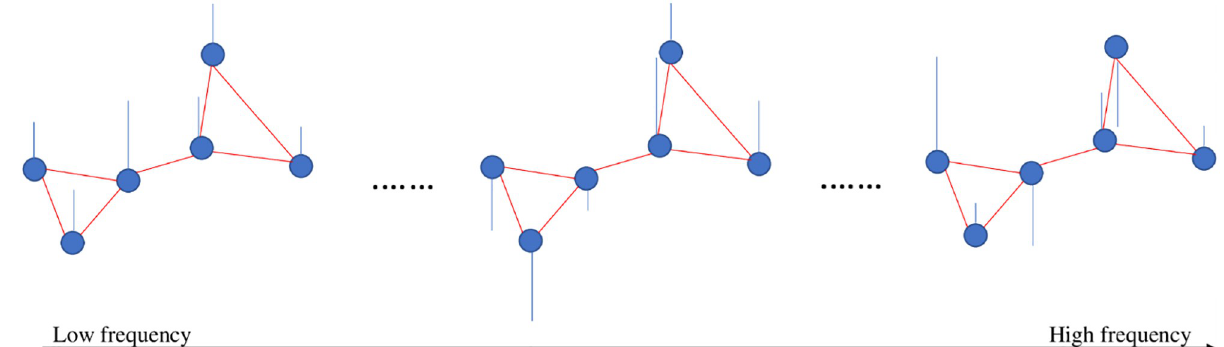
Fig 2. Simple representation of frequency concept in graph domain. In this domain, the signal changes across connected vertices define frequency levels (in the time domain, the signal changes across time points define frequency levels). Therefore, by moving from the lower frequency level to the higher frequency level of the graph, signal changes across connected vertices are increased. Blue circles and red and blue lines are vertices, edges, and signals, respectively.